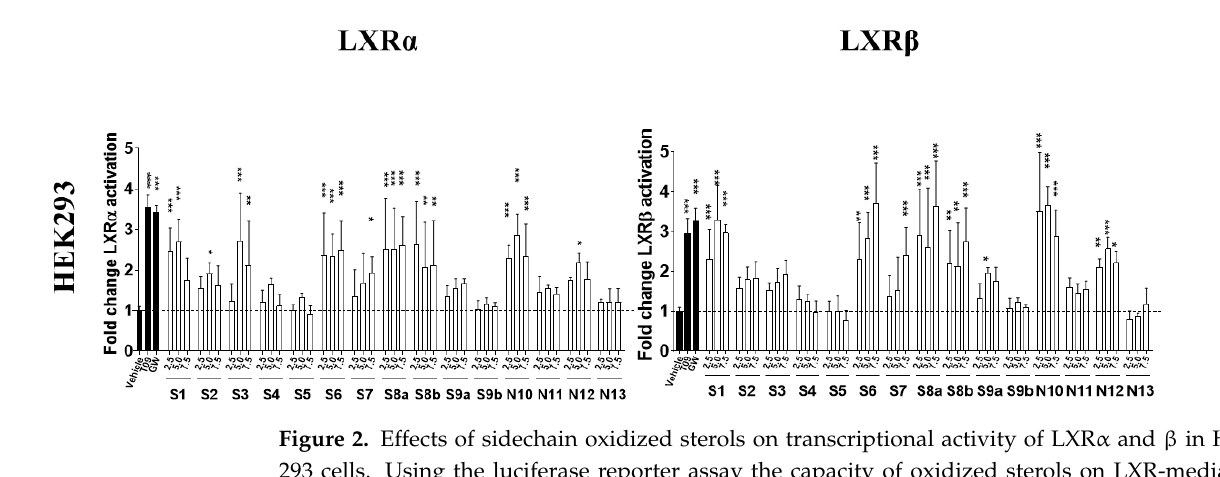
Figure 2. Effects of sidechain oxidized sterols on transcriptional activity of LXR α and β in HEK 293 cells. Using the luciferase reporter assay the capacity of oxidized sterols on LXR-mediated transcription was determined. Transfected cells were incubated with different concentrations of oxysterols (2.5, 5.0 and 7.5 µM) for 24 h. T0901317 (T09, 1 µM) and GW3965 (GW, 5 µM) were used as positive controls. Data represent the mean ± SD of three separate experiments, each performed in triplicate (n = 9). Significance is compared to the control (DMEM/F-12 medium with EtOH or DMSO) value: * p ≤ 0.05, ** p ≤ 0.01, *** p ≤ 0.001.